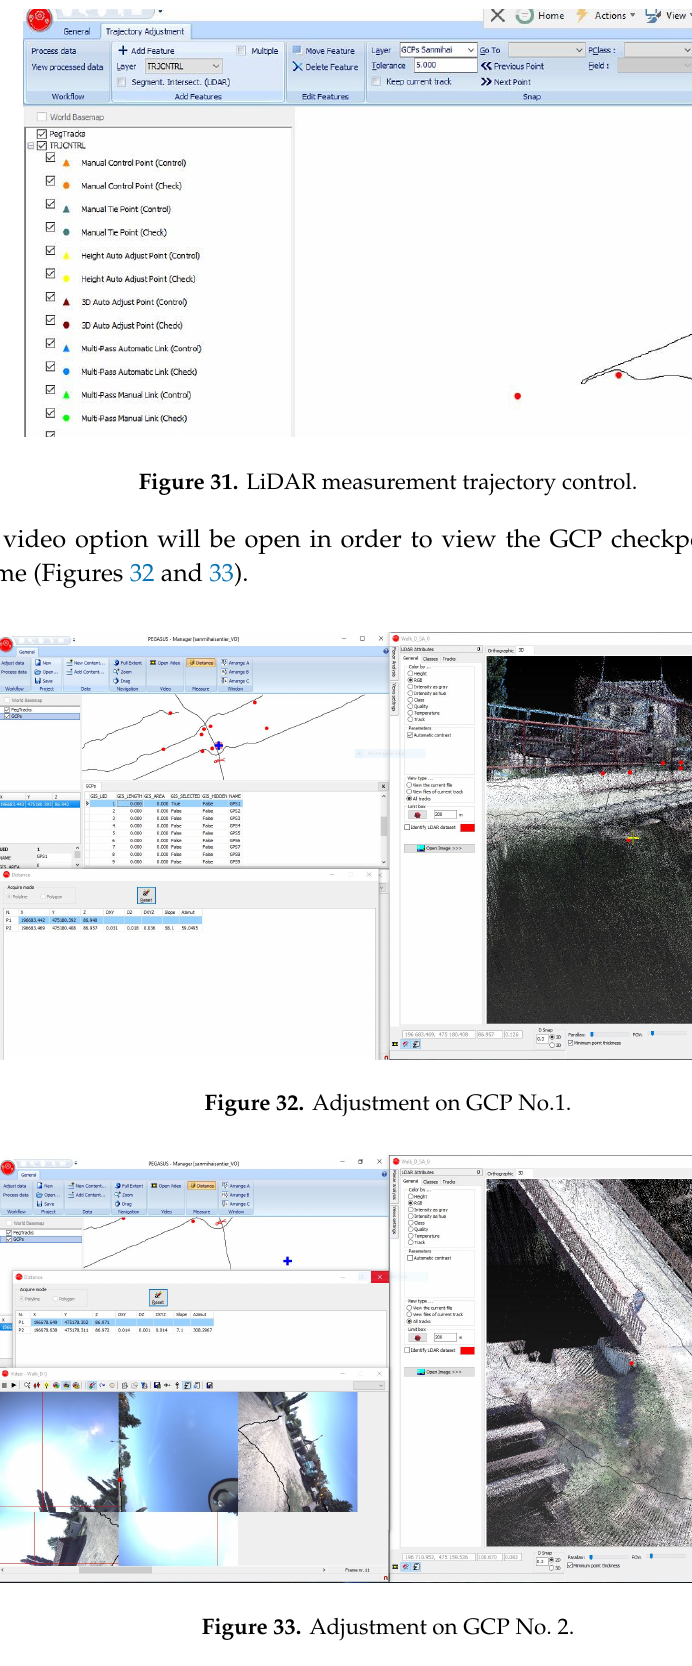
Figure 30. Import and visualization of GCPs, Sânmihaiu Român Lock.